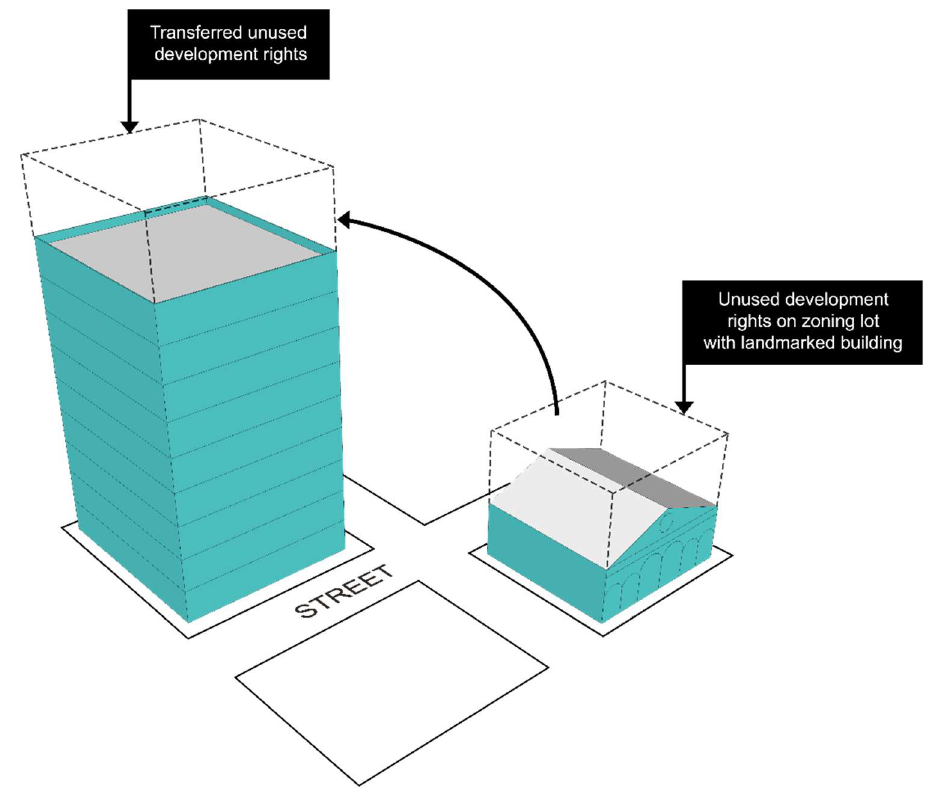
Figure 3. Transfer of development rights (illustration sourced by authors).